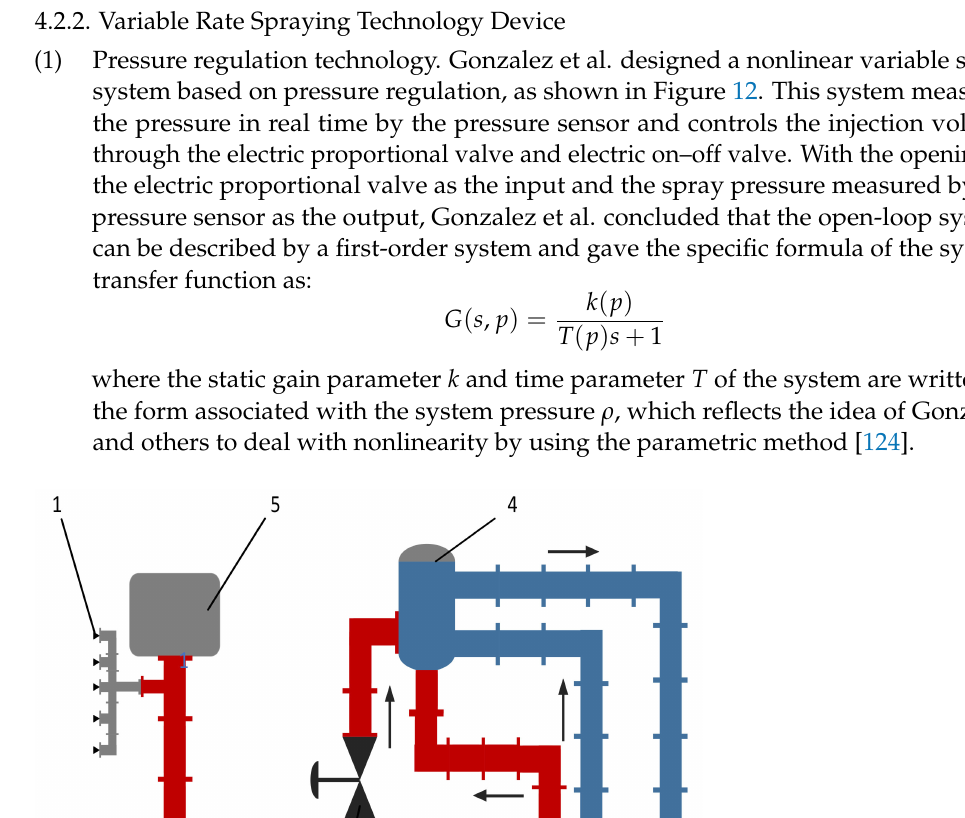
Figure 11. PWM variable nozzle. Solenoid valve on ( a ); Solenoid valve closed ( b ).